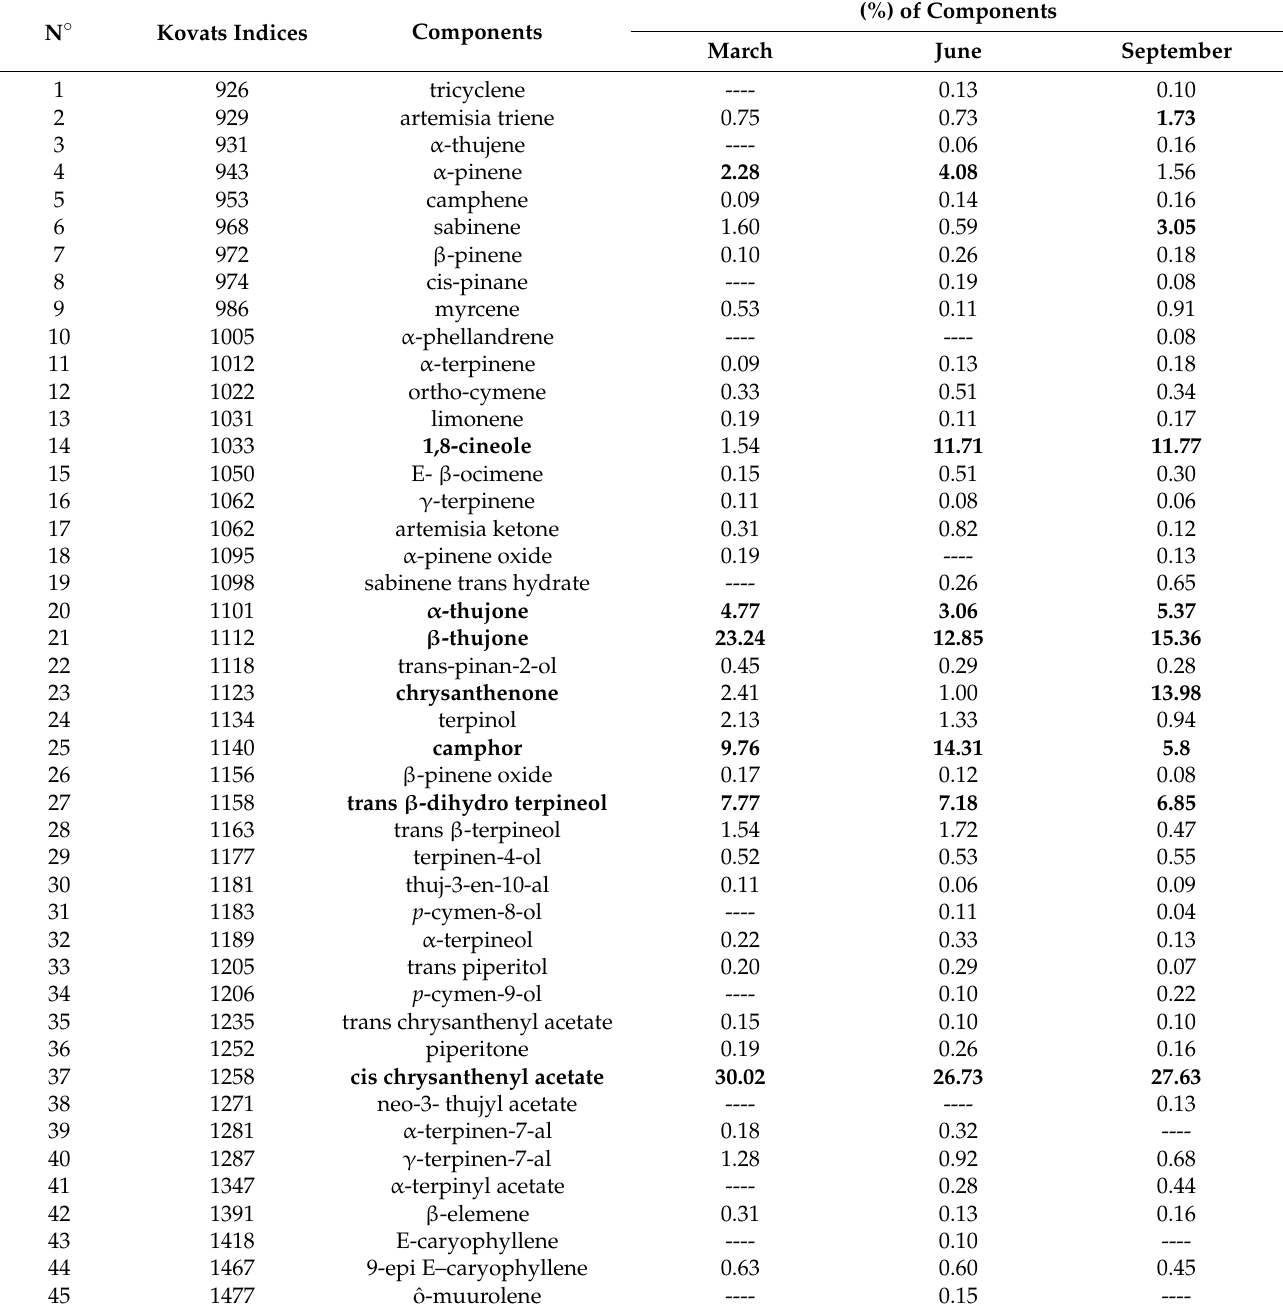
Table 1. Chemical composition of Artemisia herba-alba essential oils (March, June, and